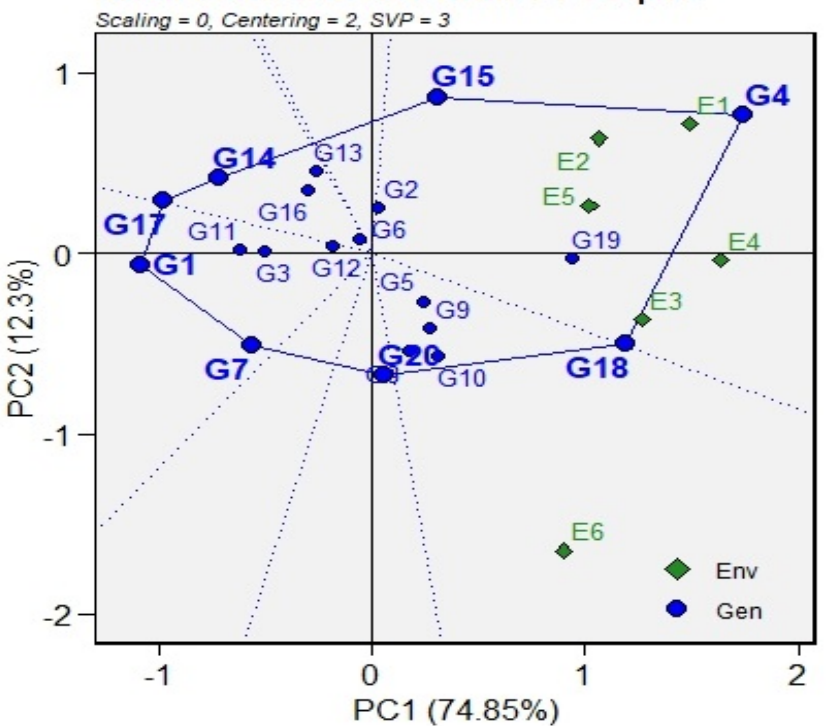
Figure 5. A “which won where” biplot based on grain yield of 20 wheat genotypes evaluated in six environments. The genotype (G) code is indicated according to Table 6.